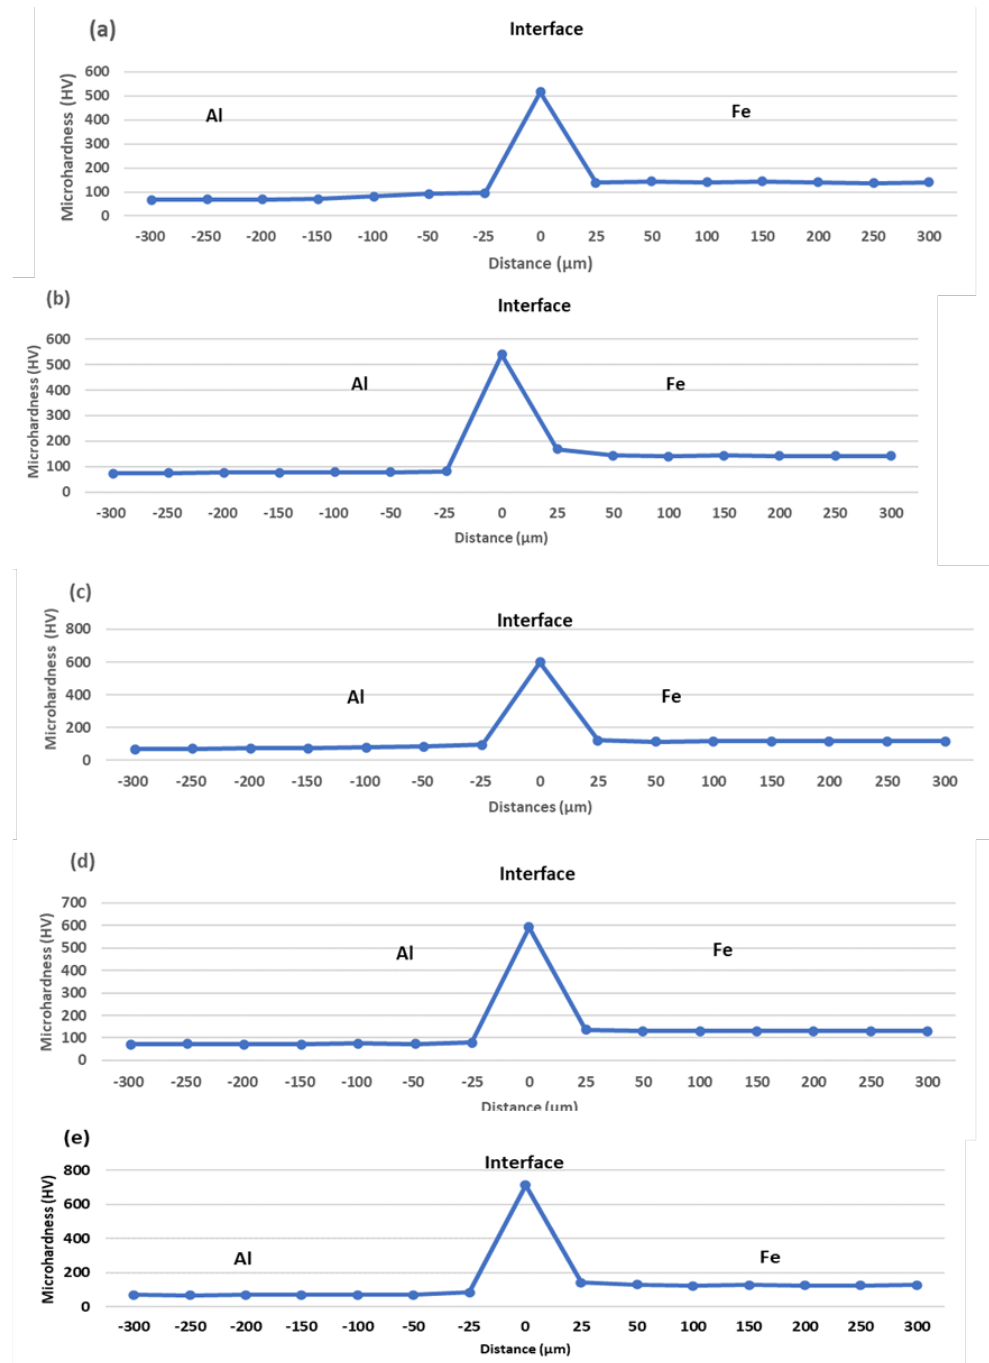
Figure 17. Microhardness distribution profile: ( a ) Sample E; ( b ) Sample F; ( c ) Sample G; ( d ) Sample H; ( e ) Sample I.